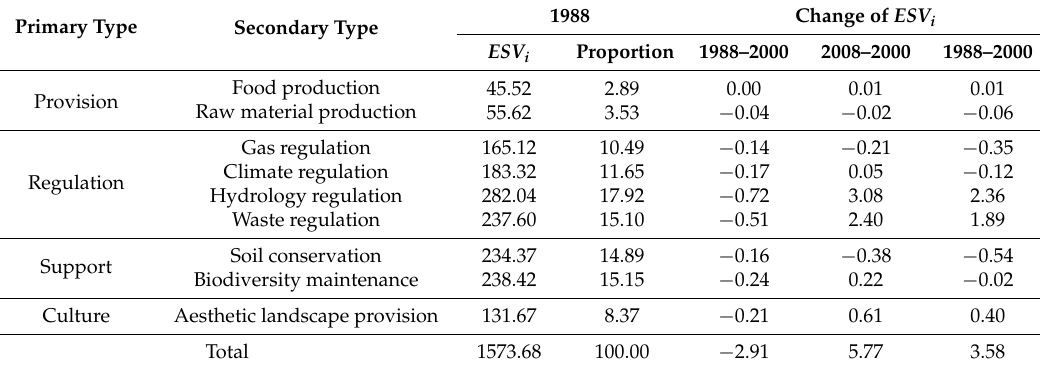
Table 5. Change of ecological service value in Qinghai Province from 1988 to 2008 (unit: a hundred million